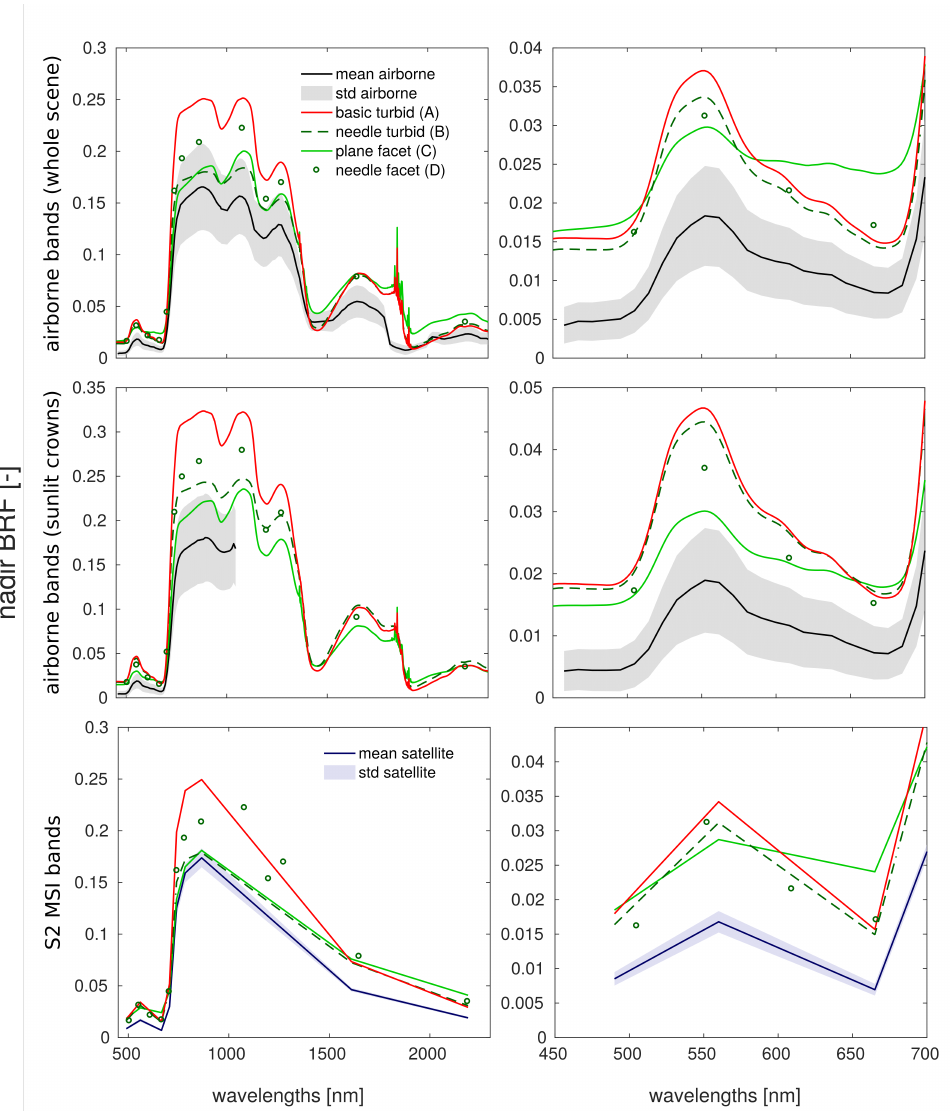
Figure 11. Comparison of DART-simulated nadir reflectance (BRF) signatures with ( a , b ) mean forest stand reflectance extracted from airborne hyperspectral CASI–SASI images (pixel size 2.5 m), ( c , d ) mean reflectance of sunlit tree crowns extracted from DART-simulated images and airborne hyperspectral CASI image (pixel size 1.0 m), and ( e – f ) mean canopy reflectance extracted from satellite Sentinel-2 MSI image (pixel size of 20 m). The left plots show close-up details of the visible spectral range (450–700